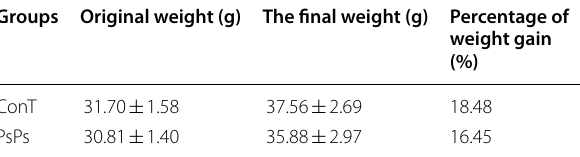
Table 2 Effects of PsPs on body weight